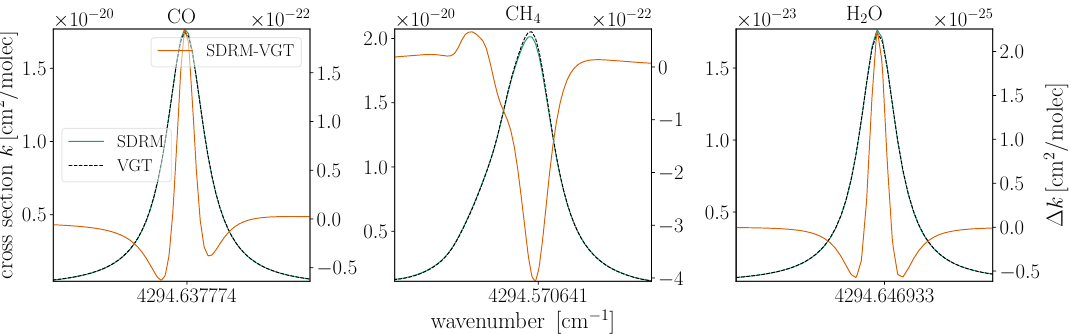
Figure 2. SDRM and Voigt (VGT) molecular cross sections for CO (left), CH 4 (center), and H 2 O (right) using SEOM data. In addition, the difference between the two line profiles (SDRM-VGT) is